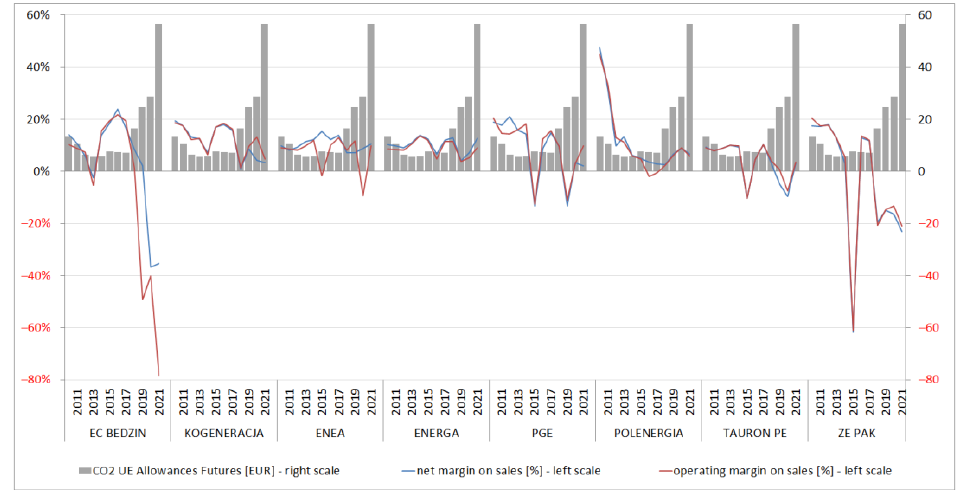
Figure 5. Net sales margin and operating margin of the surveyed energy companies (in %) vs. CO 2 rights contract prices (in EUR/ton). Source: own elaboration.